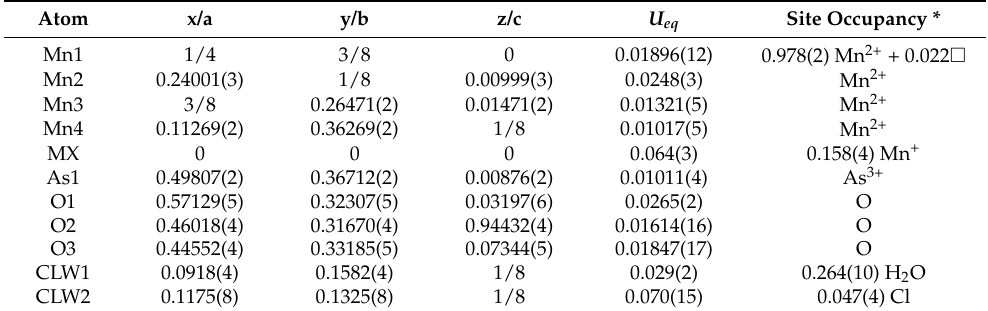
Table 3. Atom coordinates and equivalent isotropic-displacement parameters (Å 2 ) for magnussonite. U eq is defined as one third of the trace of the orthogonalized U ij tensor.